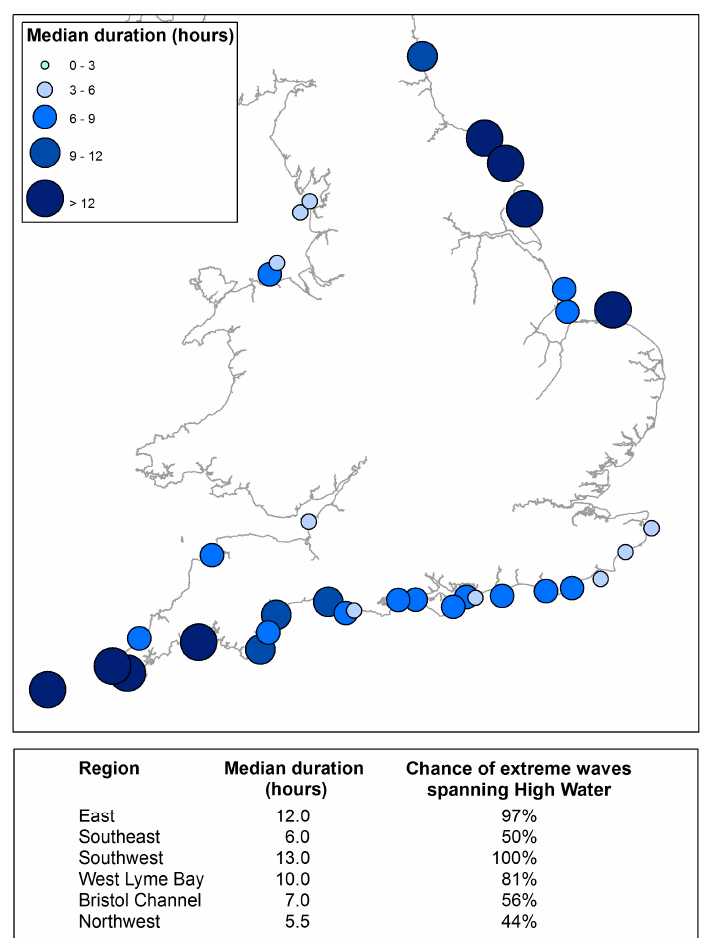
Figure 6. Median duration of storms along the English coastline.